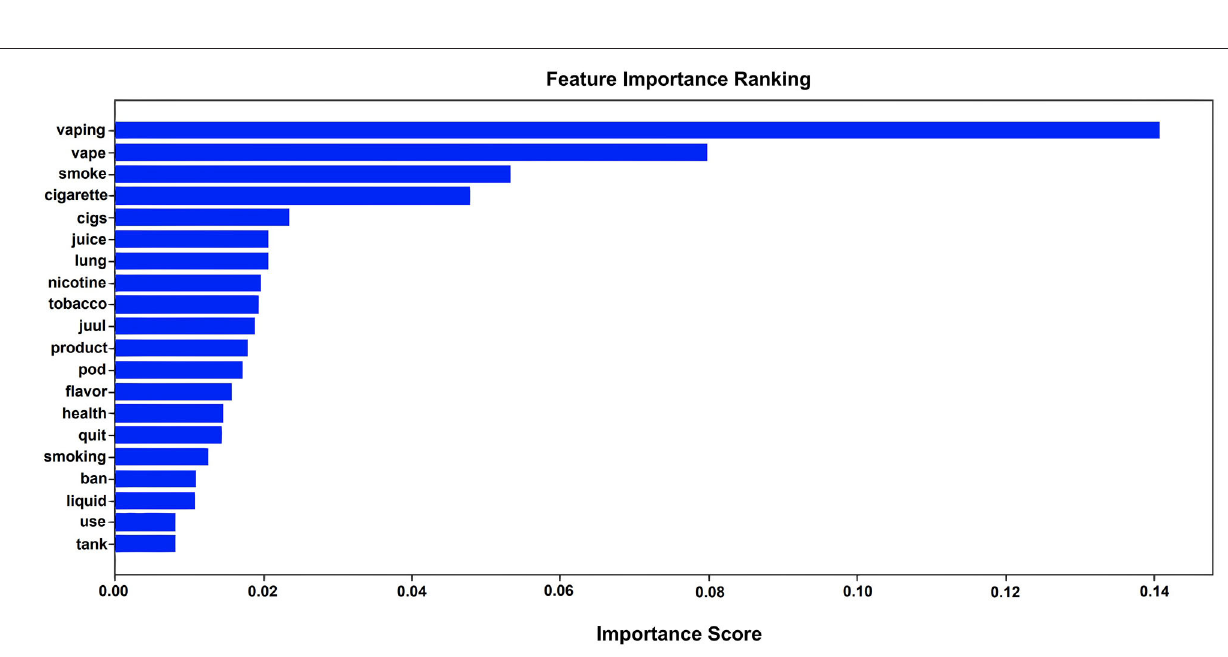
FIGURE 3 | The performance comparison for all classifiers based on percentage-based different training-testing combinations.